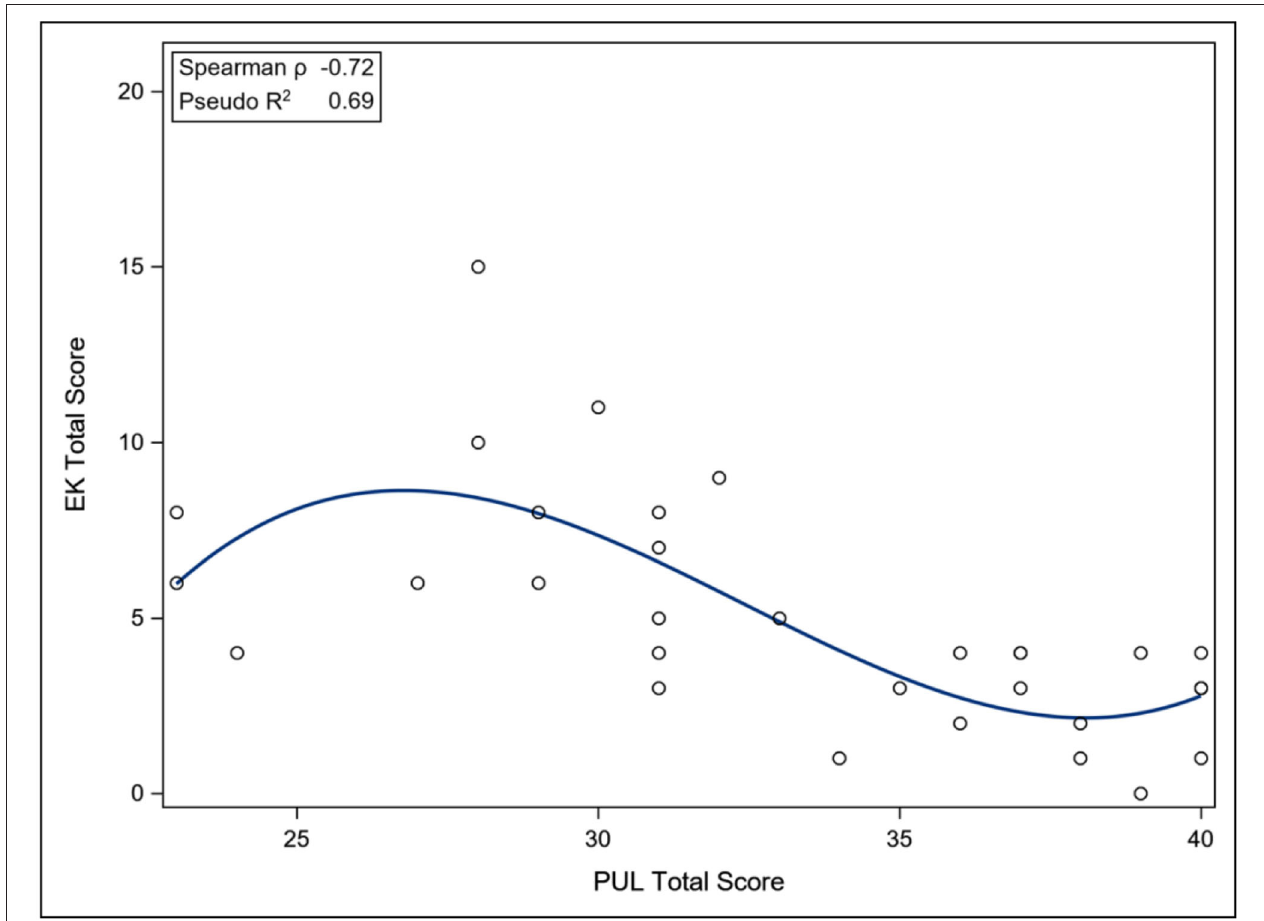
FIGURE 6 | Association between total PUL score and EK scale. EK, Egen Klassification questionnaire; PUL, Performance of Upper Limb